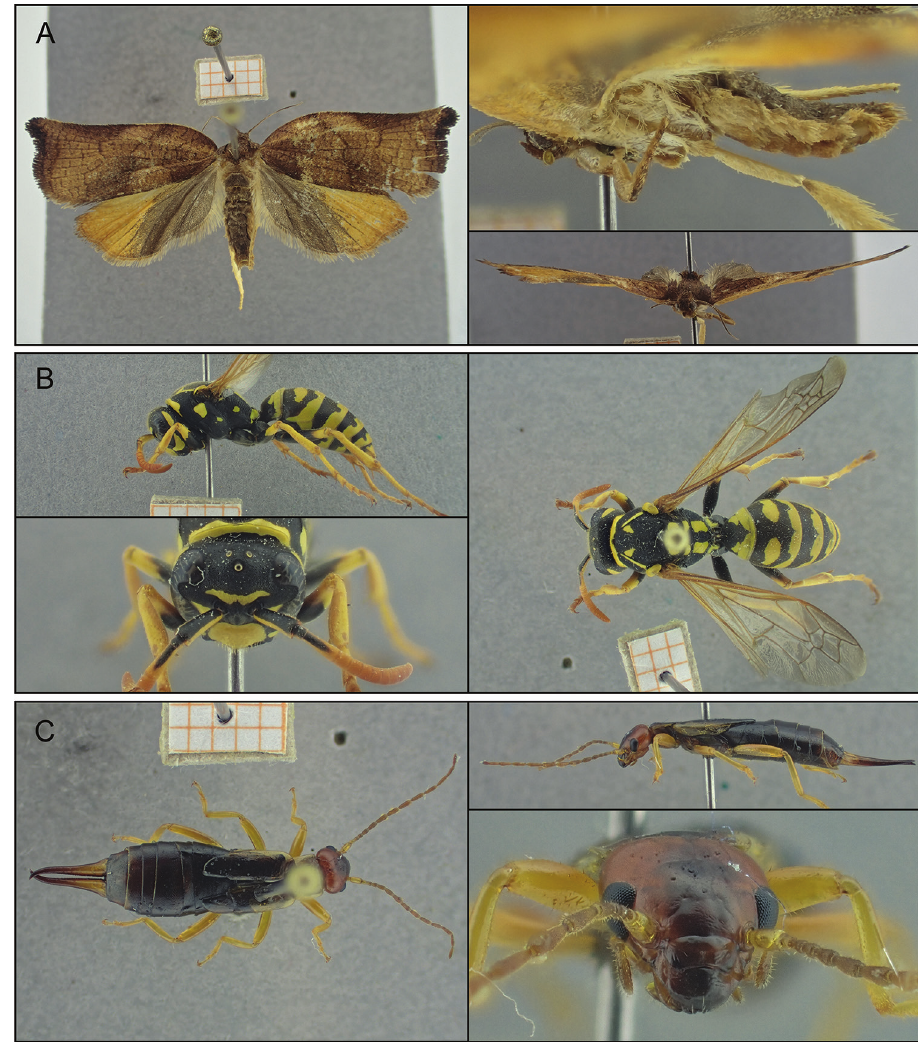
Figure 4. Images of different taxonomic groups, shot by the compact camera in manual mode (narrow setting). A large fruit-tree tortrix ( Archips podana (Lepidoptera - Tortricidae)) B European paper wasp ( Polistes dominula (Hymenoptera - Vespidae)), and C common earwig ( Forficula auricularia (Dermaptera -